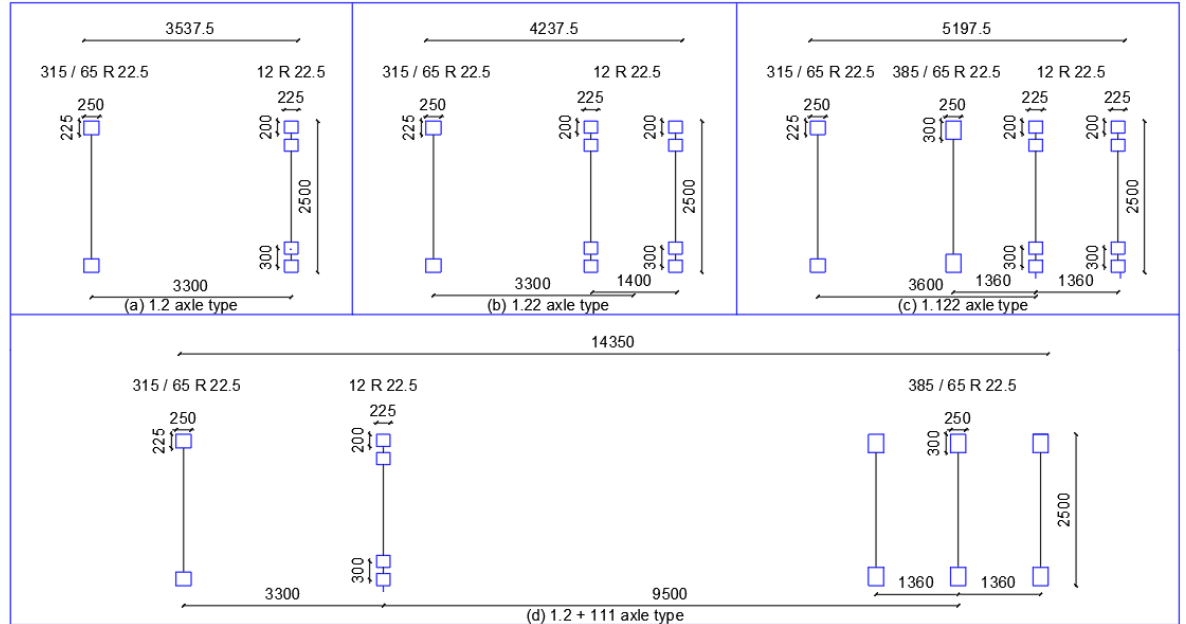
Figure 7. Modeled loading situations.